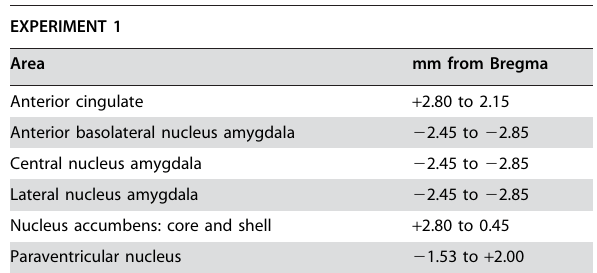
Table 1. Brain areas: Swanson (1992) rostral-caudal